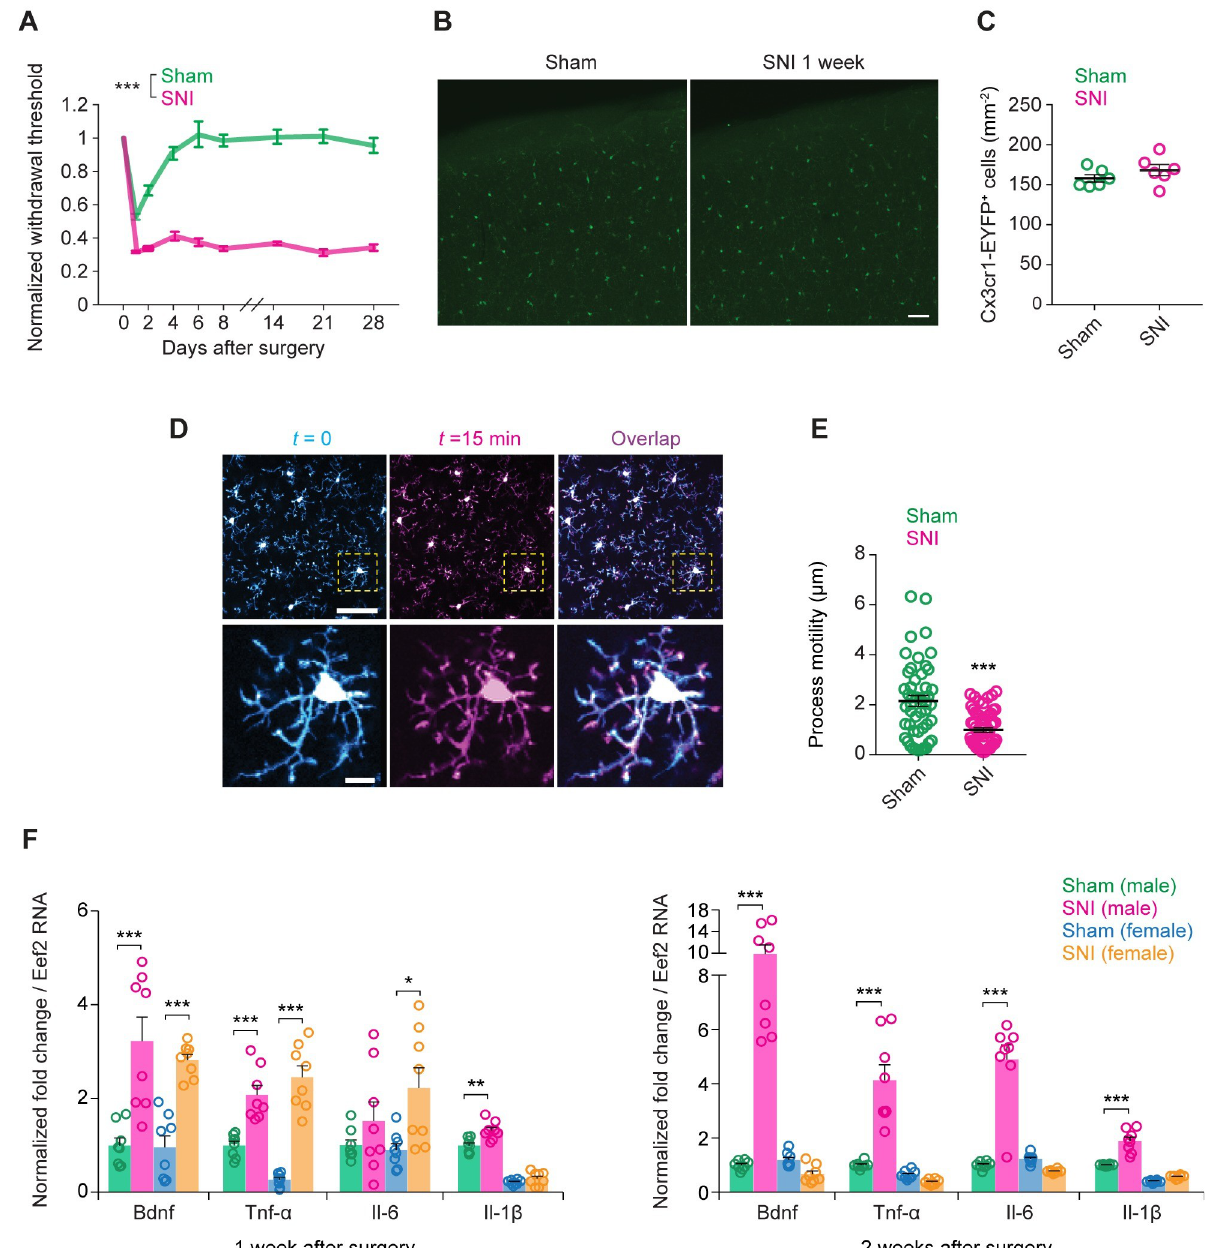
Fig 1. Microglia maintain normal morphology and density in the S1 after peripheral nerve injury but increase gliotransmitter expression. ( A ) Paw withdrawal threshold before and after SNI ( n = 14 mice) or sham ( n = 10 mice) surgery ( F 1,22 = 569.6, P < 0.001). ( B ) Coronal sections of S1 from 2- to 3-month-old Cx3cr1 CreER-EYFP mice stained for EYFP. Scale bar, 50 μ m. ( C ) Quantification of microglia ( Cx3cr1 -EYFP + cell) density in the S1 of sham and SNI mice 1 week after surgery ( t 10 = 1.206, P = 0.2556; n = 6 mice per group). Individual circle represents data from a single animal. ( D ) Motility of microglial process in the S1 was measured by intravital two-photon imaging 1 week after surgery. Scale bar, 50 μ m (top) and 10 μ m (bottom). ( E ) Quantification of S1 microglial process extensions and retractions over 15 min in sham and SNI mice ( t 107 = 5.196, P < 0.0001; n = 6 mice per group). Individual circle represents data from a single cell. ( F ) Bdnf , Tnf - α , Il -6, and Il- 1 β mRNA expression in S1 microglia 1 week and 2 weeks after surgery ( n = 8 mice per group). Summary data are presented as mean ± SEM. � P < 0.05, �� P < 0.01, ��� P < 0.001; by an unpaired t test (C, E), two-way ANOVA followed by Bonferroni multiple comparisons test (A), or one-way ANOVA followed by Bonferroni multiple comparisons test (F). (B, D) Representative images from experiments carried out on at least 5 animals per group. The data underlying this figure can be found in S1 Data. EYFP AU : AbbreviationlistshavebeencompiledforthoseusedinFigs 1 (cid:0) 8 : Pleaseverifythatallentriesarecorrect : , enhanced yellow fluorescent protein; SNI, spared sciatic nerve injury; S1, primary somatosensory cortex.